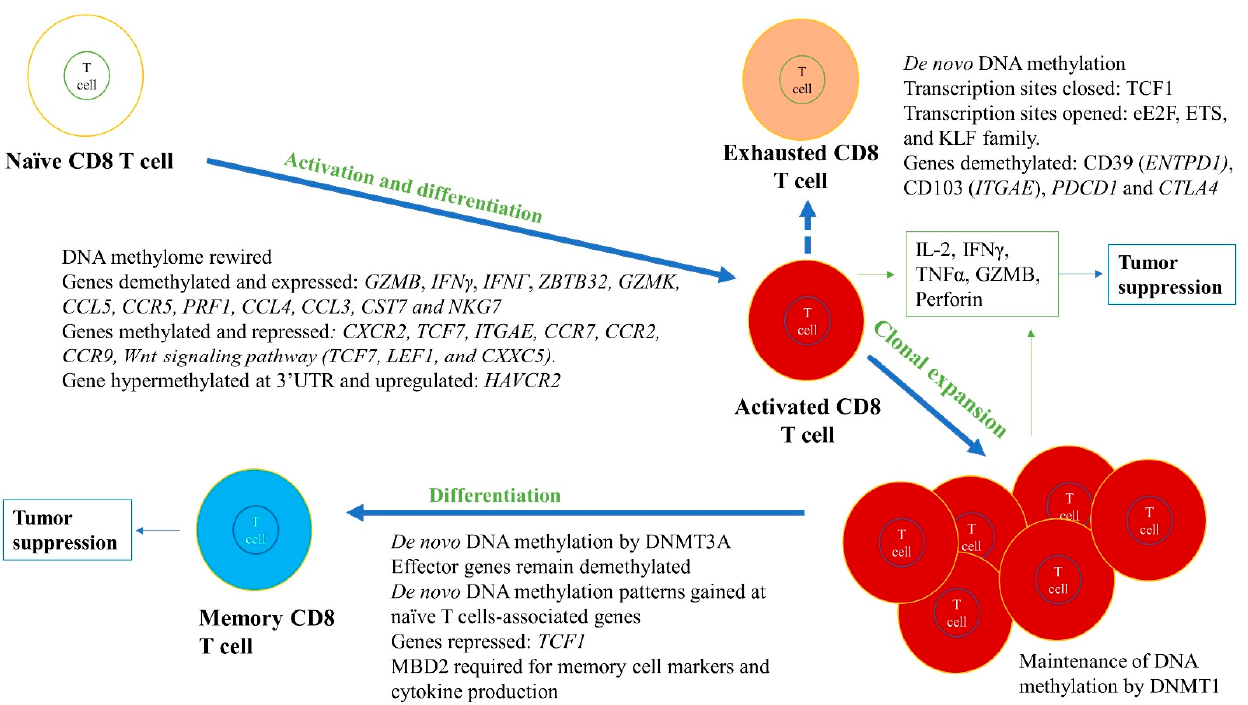
Figure 4. Role of DNA methylation in regulating differentiation and activation of naïve CD8+ T cells into effector cells, including cytotoxic and memory T cell subtypes. DNA methylation changes during differentiation and activation can lead to formation of subtypes of CD8+ T cells. For instance, cytotoxic CD8+ T cells are formed due to whole genome remodeling and expression, and repression of various genes in naïve CD8+ T cells. The genes that are essential for activation, proliferation, and effector functions are demethylated and highly expressed, such as IL-2 , IFNG or IFN γ , and GZMB , whereas genes that are not required are methylated and repressed (e.g., TCF7 ). Although methylation and gene silencing are usually positively correlated, there are examples of genes that could be methylated and expressed, such as HAVCR2 , depending upon the precise location of the methylation. In memory CD8+ T cell differentiation, effector genes remain demethylated, whereas methylation at naïve T cell-associated genes are gained and repressed, such as in the case of TCF1 . These methylation levels are maintained by DNMT1, DNMT3A, and TET2. The green boxes indicate the cytokines released from differentiated cells. These immune cells and released cytokines can further lead to tumor suppression and elimination. However, CD8+ T cells can become exhausted in the TME, highly expressing exhaustive markers such as CD39, CD103, PD-1, and CTLA-4. The exhausted CD8+ T cells are non-functional and produce low amounts of effector cytokines (e.g., IFN γ ).